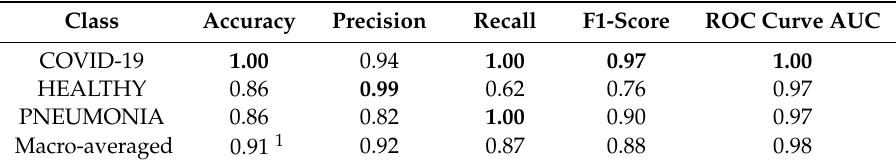
Table 5. Performance measures of the classification task with the proposed model.